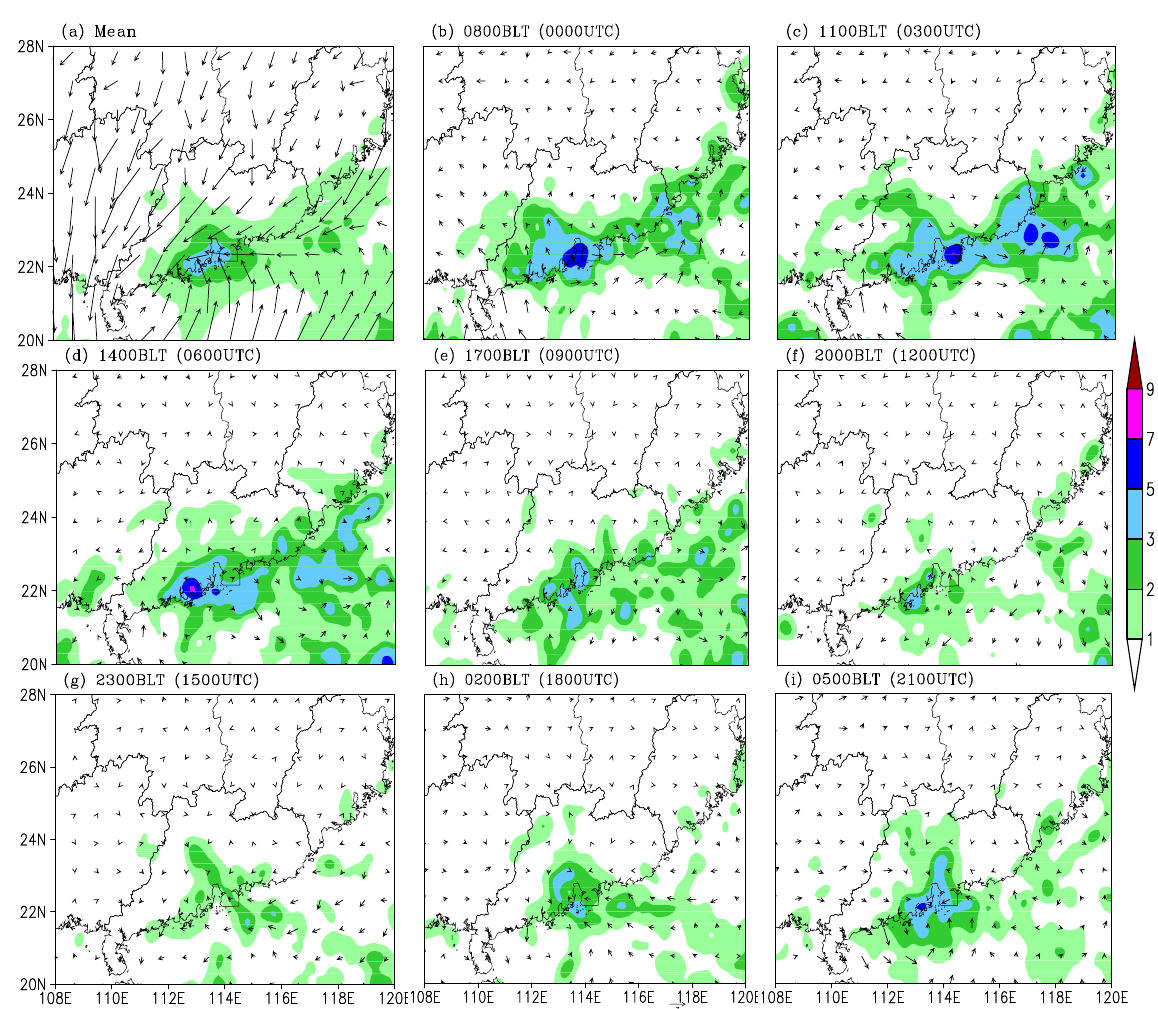
Figure 11. The results of Exp ND for mean hourly rainfall (shaded, unit: mm) and 10-m wind (contours, unit: m·s –1 ) ( a ) and the diurnal evolution of rainfall intensity (shadings, unit: mm·h –1 ) and anomalous 10-m wind (vectors, unit: m·s –1 ) at ( b ) 0800 BLT, ( c ) 1100 BLT, ( d ) 1400 BLT, ( e ) 1700 BLT, ( f ) 2000 BLT, ( g ) 2300 BLT, ( h ) 0200 BLT and ( i ) 0500